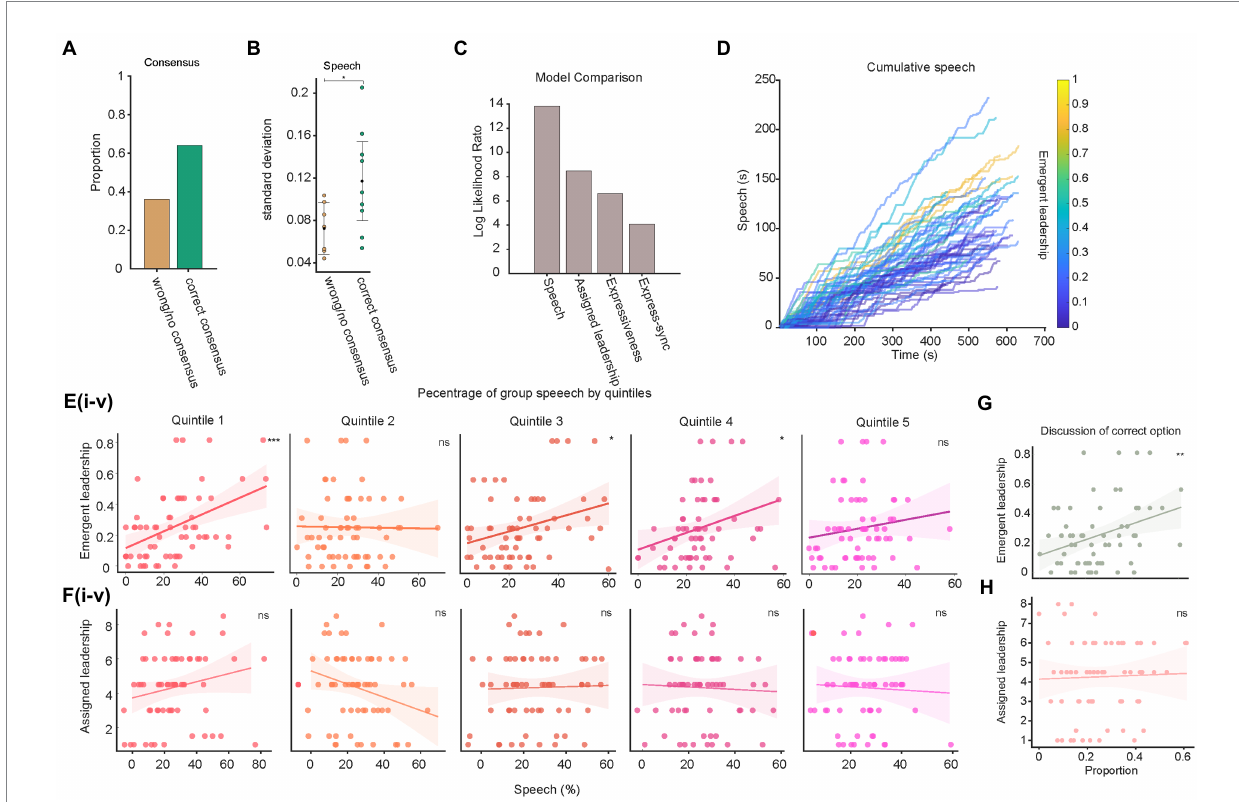
FIGURE 2 Communication style predicts emergent leadership attribution. (A) Proportion of 16 sessions that reached the correct consensus. (B) Standard deviation of speech percentage between correct consensus and incorrect groups. (C) Log likelihood ratio of reduced models compared to best models. (D) Cumulative speech for each participant session color temperature indicates emergent leadership score. (E,F) Relationship between percentage of speech and (E) emergent or (F) assigned leadership by each participant in a session split into five (i–v) quintiles. (F) Percentage of speech and assigned leadership proportion by each participant in a session split into five quintiles. (G,H) Relationship between each proportion of each group’s discussion of the correct outcome by each participant and emergent and assigned